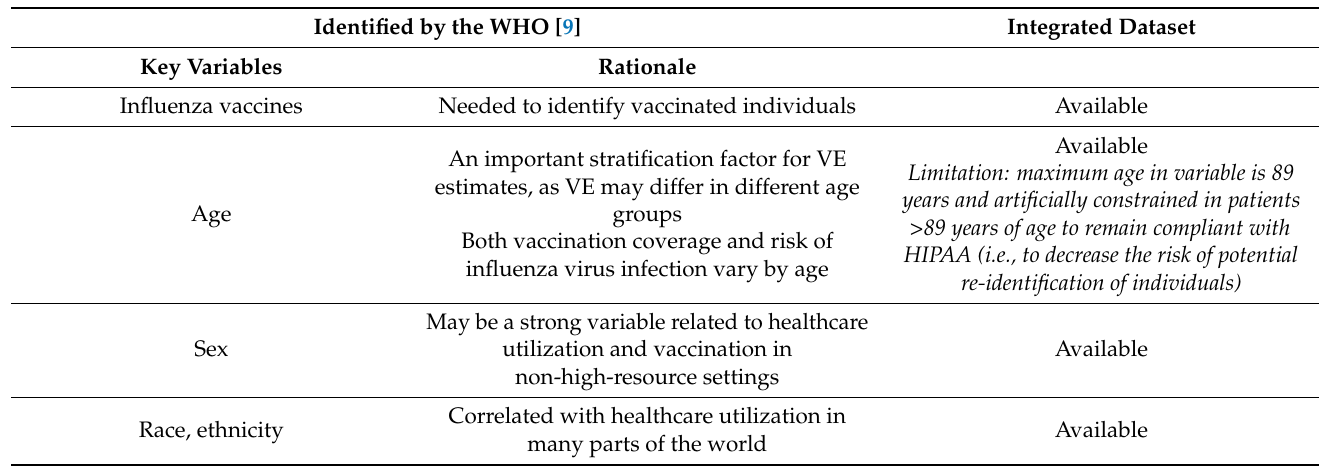
Table 1. Availability of variables within the Integrated Dataset for the evaluation of influenza vaccine effectiveness compared with WHO benchmarks